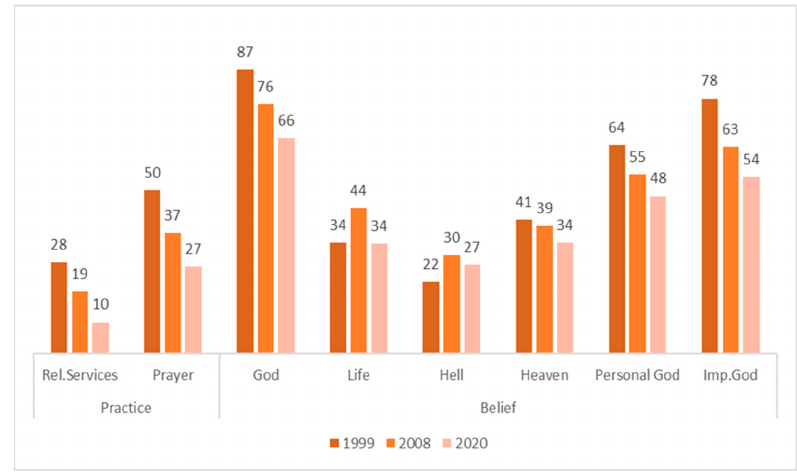
Figure 5. Practice and belief variables by round in Portugal in 2020 (%). Source: EVS (2021). Notes: Significant differences exist between all rounds with the following exceptions: in belief in Life after death, there are significant differences only between 2008 and 2020; in belief in Hell, there are no significant differences between all age groups; in belief in Heaven, there are significant differences only between 1999 and 2020; in belief in Personal God, there are no significant differences between 2008 and 2020. Tests: Rel.Services—Fw (2) = 20.242, p < 0.001. Prayer—Fw (2) = 19.593, p < 0.001. God—Fw (2) = 33.732, p < 0.001. Life—Fw (2) = 6.634, p = 0.001. Hell—Fw (2) = 2.491, p = 0.084. Heaven—Fw (2) = 3.012, p = 0.050. Personal God—Fw (2) =7.872, p < 0.001. Imp.God—Fw (2) = 21.550, p < 0.001. In all, normality assumed, and homogeneity of variances not assumed.